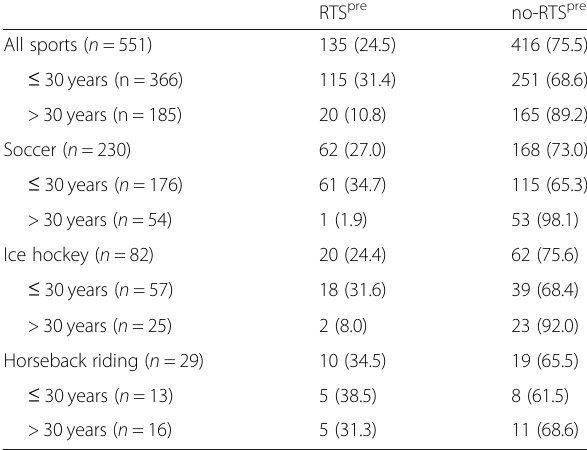
Table 3 RTS pre and no-RTS pre for the entire group, the most common sports and by age groups